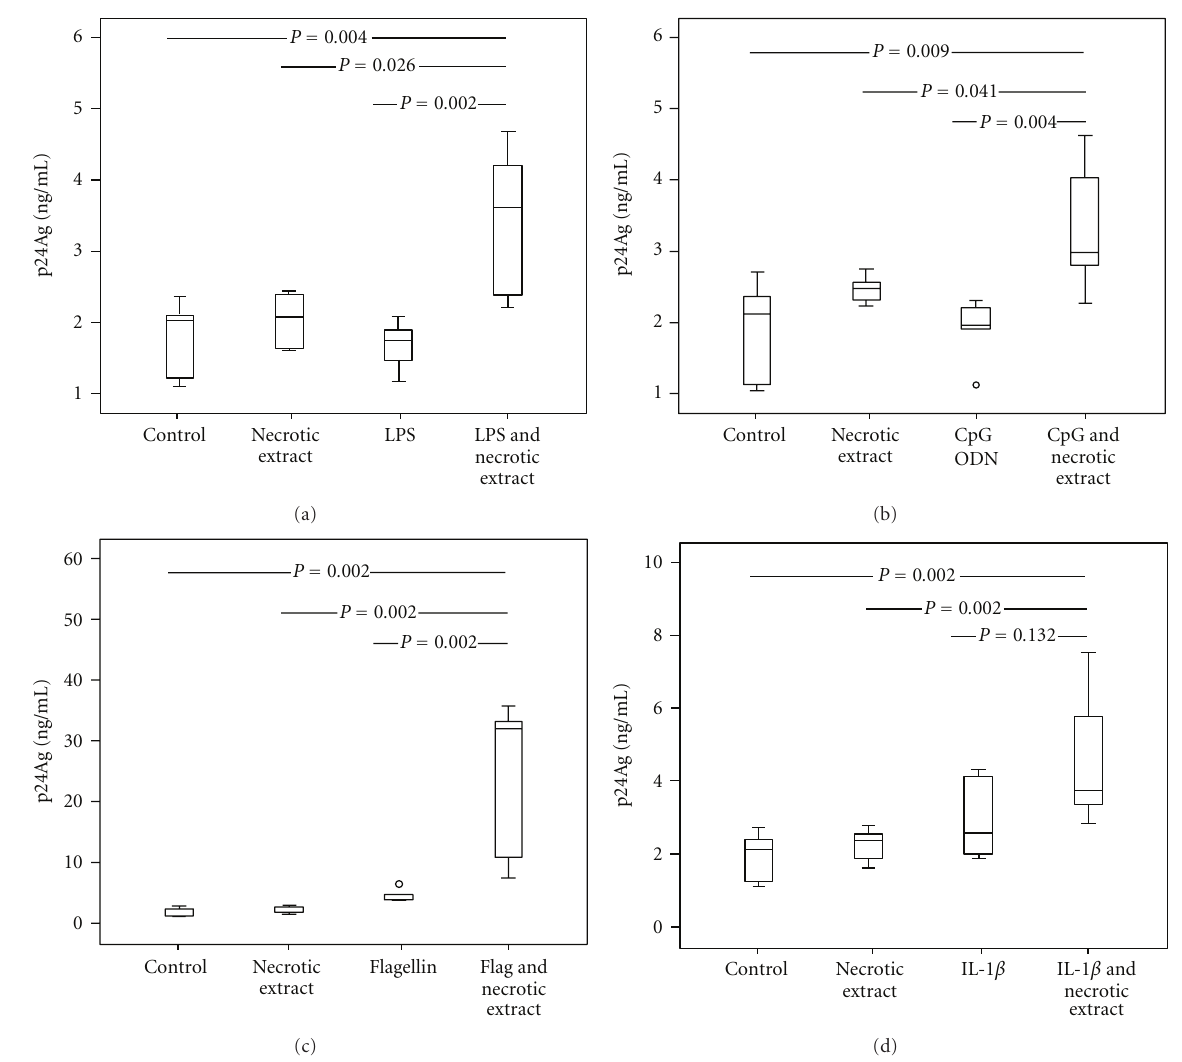
Figure 2: Necrotic extract and TLR-ligands in complexes upregulate viral replication in U1cells. U1 cell cultures were stimulated with necrotic extract (HMGB1 concentration 1 μ g/mL) and Toll-like receptor ligands: LPS 10 ng/mL (a), CpG-ODN 1 μ g/mL (b), flagellin 50ng/mL (c), and IL-1 β 0.25 ug/mL (d) alone or in complexes. Supernatants from mock cells served as controls. Supernatants were collected from cell cultures after 72 hours. Results from three independent experiments in duplicates are presented.